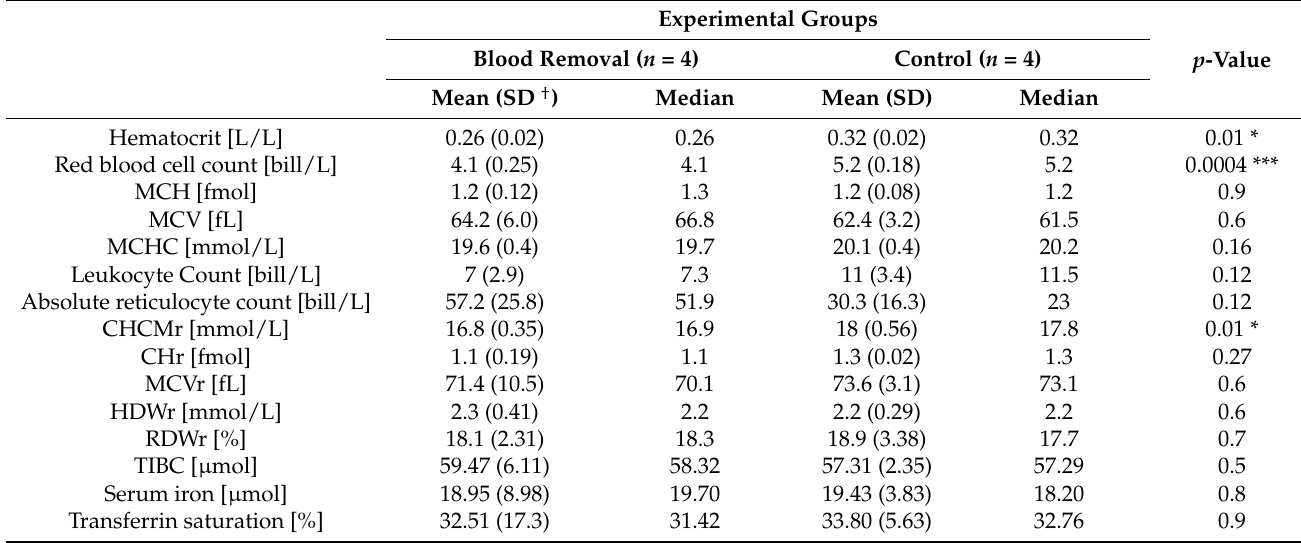
Table 2. Hematologic parameters for sows at farrowing in trial